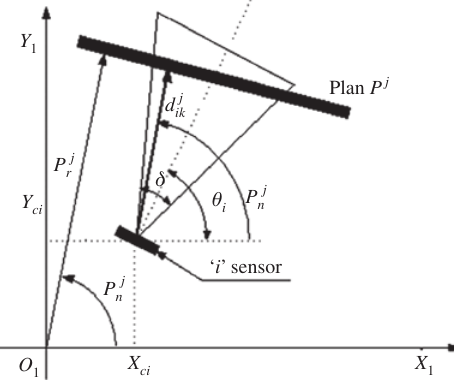
Figure 4: Distances Measured by the Ultrasonic